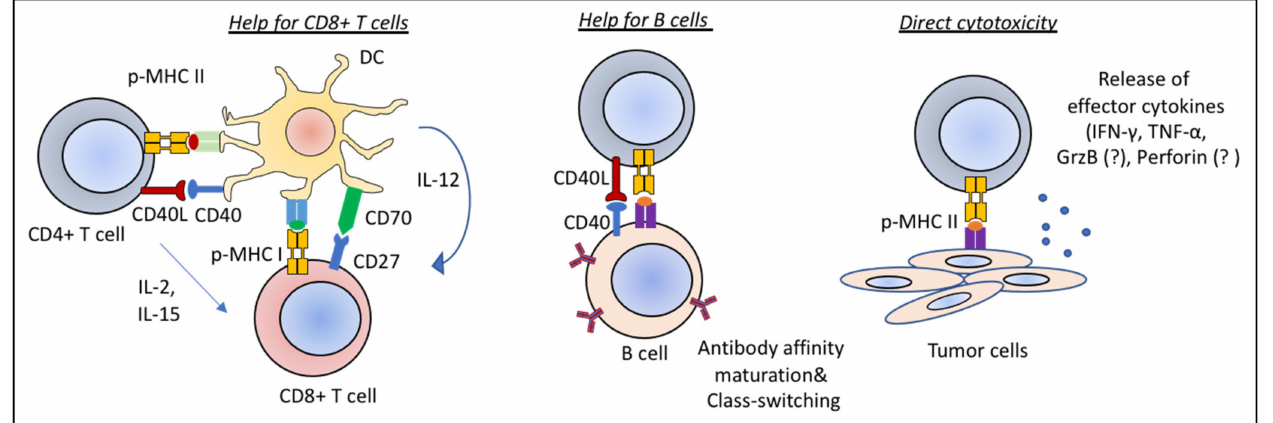
Figure 2. Antitumor functions of CD4+ T cells. CD4+ T cells exert antitumor functions by helping CD8+ T cells and B cells, and through direct cytotoxicity. Licensing of DCs by CD40–CD40L interactions is critical for priming of CD8+ T cells (left). The CD40–CD40L axis also orchestrates CD4+ T cell help to B cells leading to antibody affinity maturation and isotype-switching (middle). CD4+ T cells are also able to perform direct cytolytic functions whereby IFN- γ and TNF- α play critical roles. A direct cytotoxicity of CD4+ T cells against tumors by release of Granzyme B and Perforin, a known phenomenon during viral infections, likely also takes place in tumors